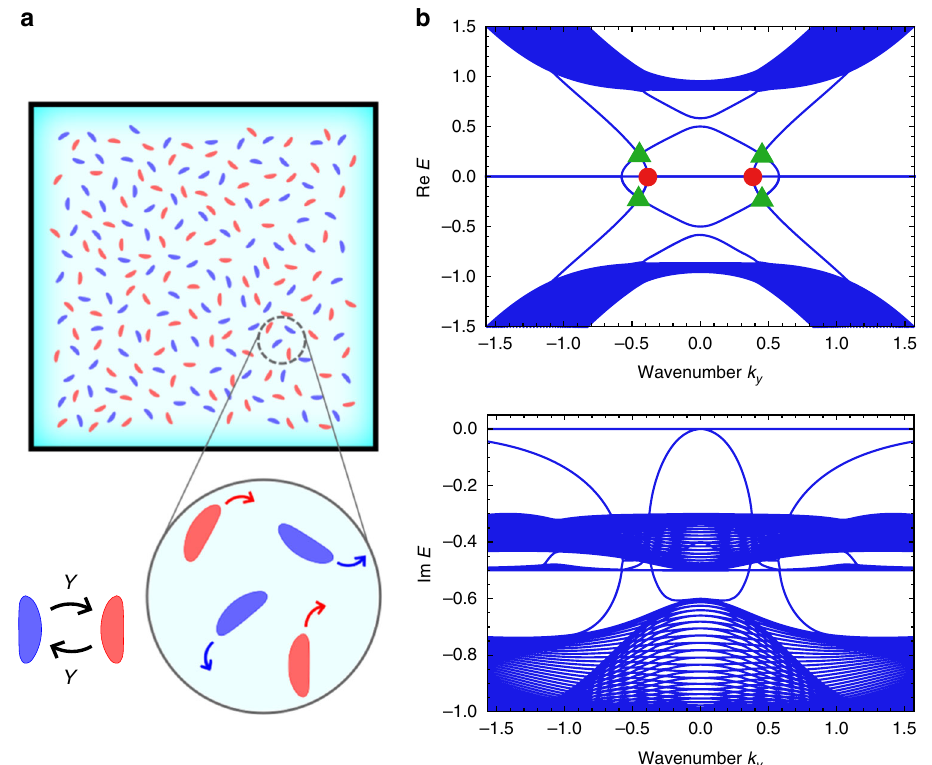
Fig. 7 Exceptional edge modes in chiral active matter. a Two-component chiral active matter is considered, where each active particle tends to move in the left (right) direction as shown in the blue (red) arrow. These two types of chiral active matter are mixed and the chirality can fl ip at a constant rate. b The edge band structure calculated for the cylindrical system is shown. The negativity of the imaginary part of eigenenergies implies the linear stability of the steady state. Since there exist four bands per edge in the bulk gap, the bulk topology is trivial in the conventional sense. The red circles represent the EPs that lead to the robustness of the edge modes. Also, we can fi nd apparent edge-band crossings in the bulk real energy gap, which are denoted as the green triangles. However, the edge modes do not really cross there, because they avoid each other in their imaginary parts of the eigenenergies. Therefore, the apparent degeneracies are artifacts, and thus the gapless edge modes are not broken by disorder. The other crossings on the Re E ¼ 0 axis correspond to the points where the edge bands come out of the bulk bands. The parameters used are ω 0 = 1, ν o = 0.5, γ = 0.3, and β =